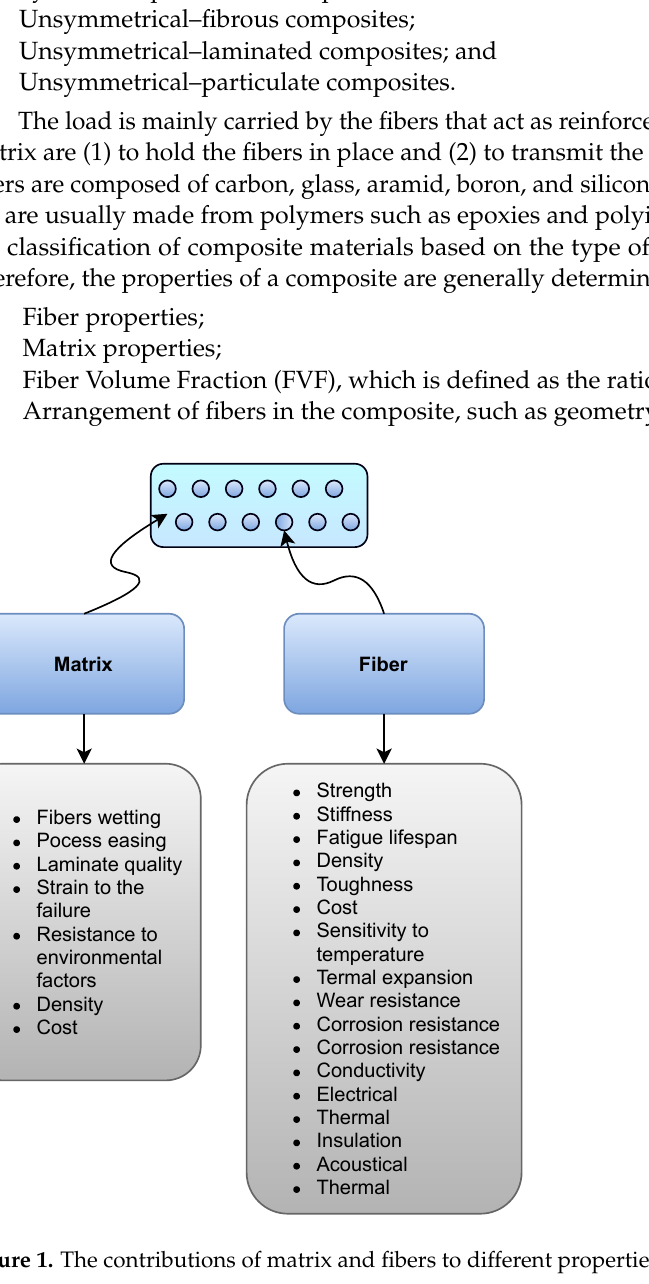
Figure 1. The contributions of matrix and fibers to different properties of a